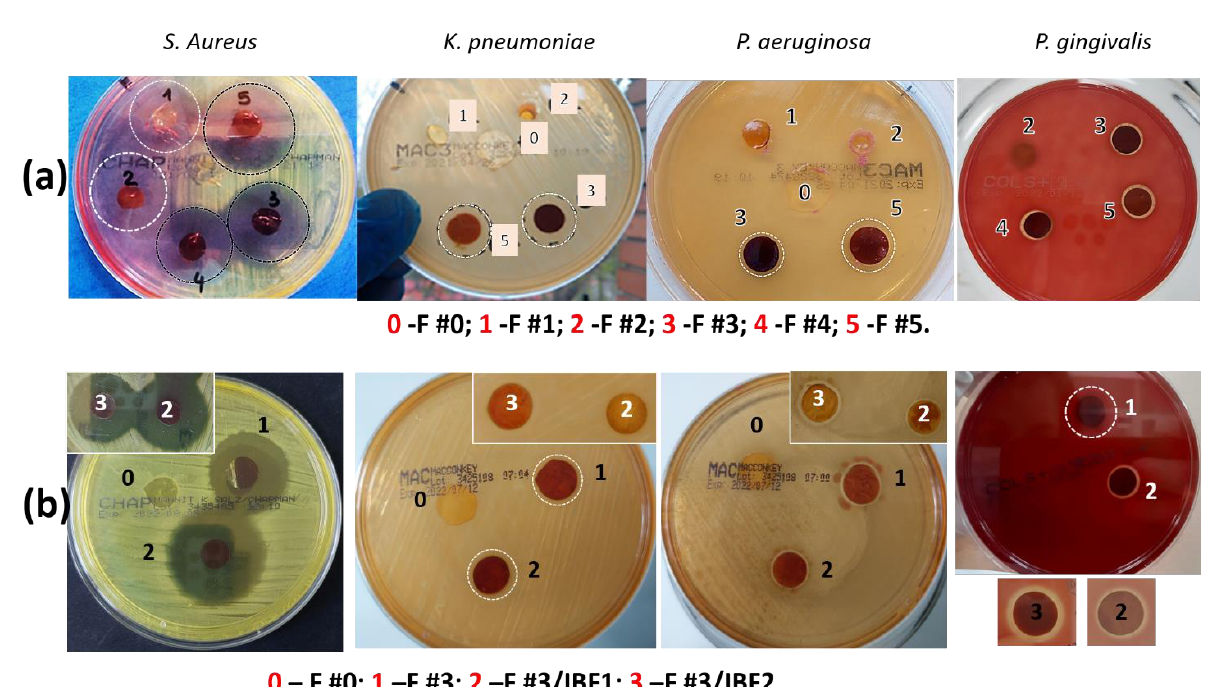
Figure 10. Comparative studies of antibacterial activity of pure and composite PVA/OxCS-Ag films ( a ) and of unloaded and ibuprofen-loaded composite films ( b ) against S. aureus , K. pneumoniae , P. aeruginosa , and P. gingivalis bacteria.